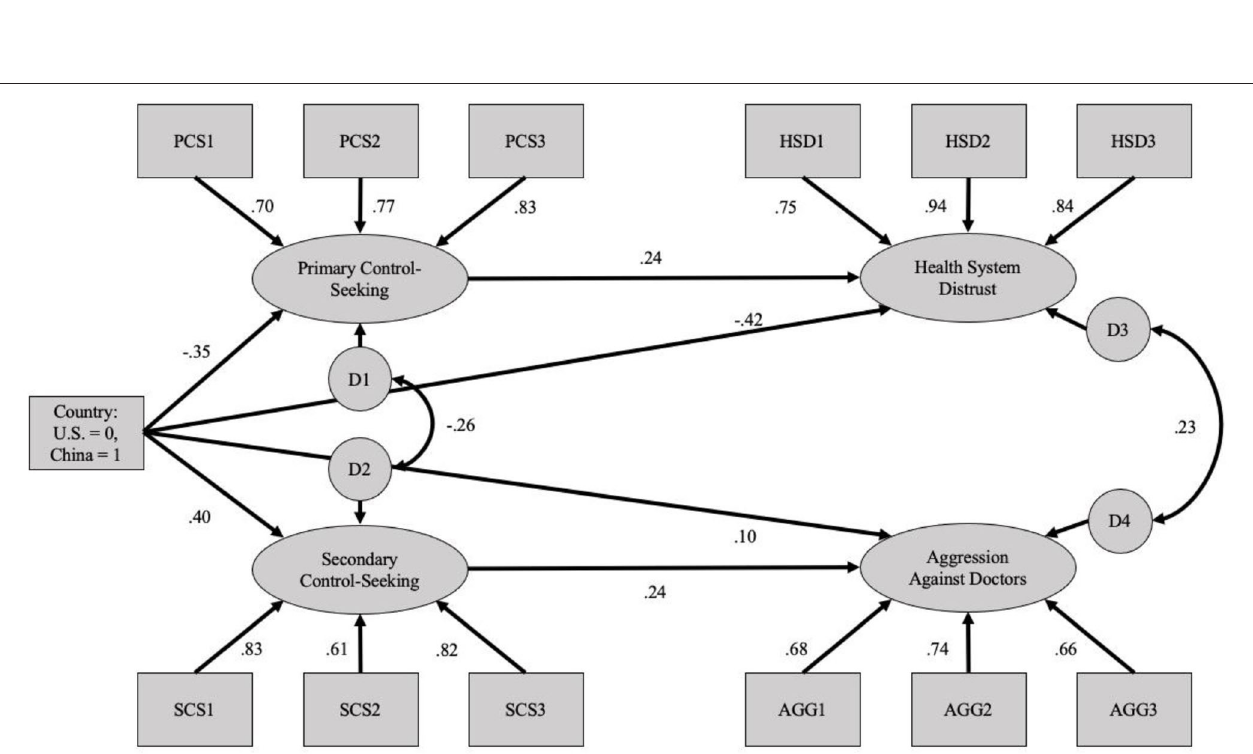
FIGURE 3 | Full structural equation model using the COVID-19 uncertainty scenarios (Study 2).